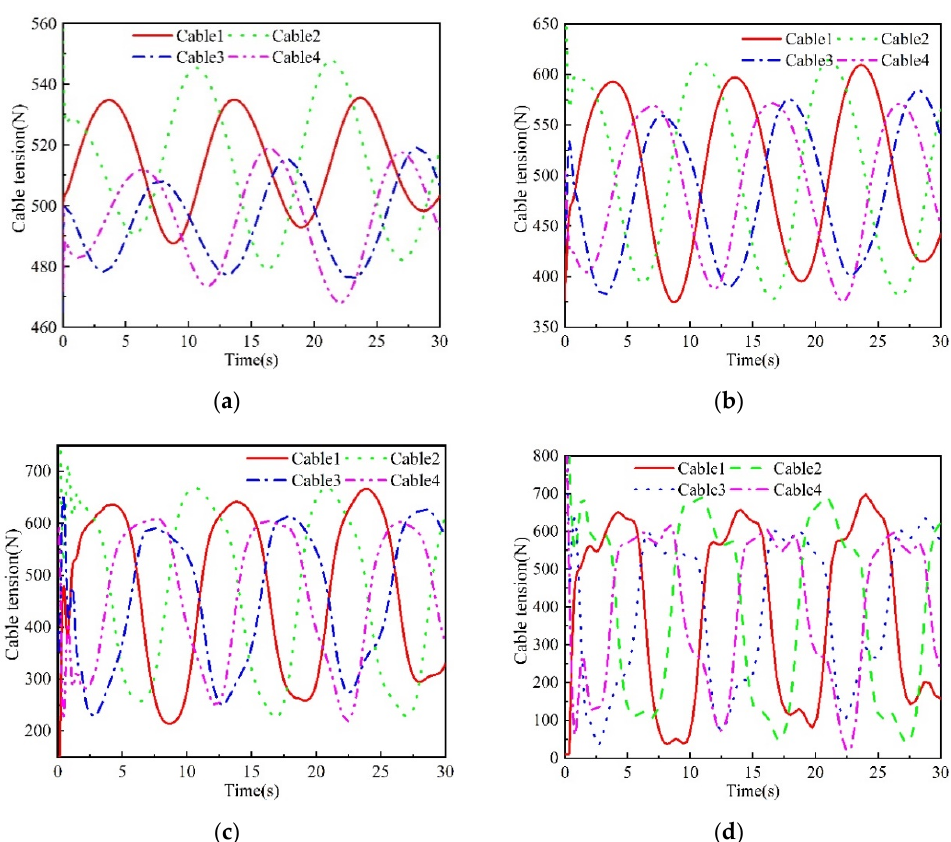
Figure 6. Cable tensions at different speeds: ( a ) Low-speed motion v = 0.6 m/s; ( b ) Medium speed motion v = 3.1 m/s; ( c ) High-speed motion v = 6.3 m/s; ( d ) Ultra-high-speed motion v = 9.4 m/s.